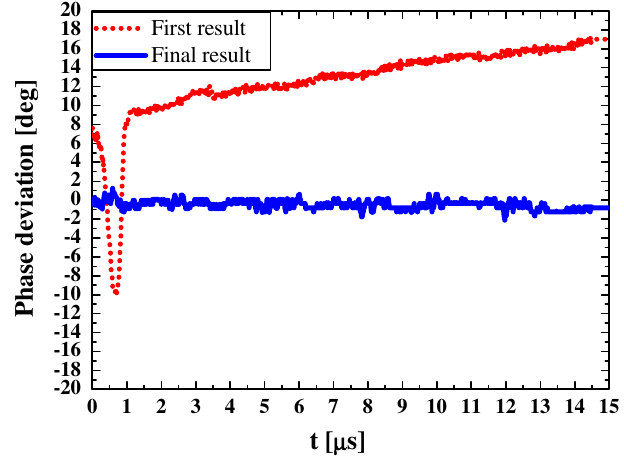
FIG. 15. (Color) First and final results of deviation in the klys- tron output (phase).